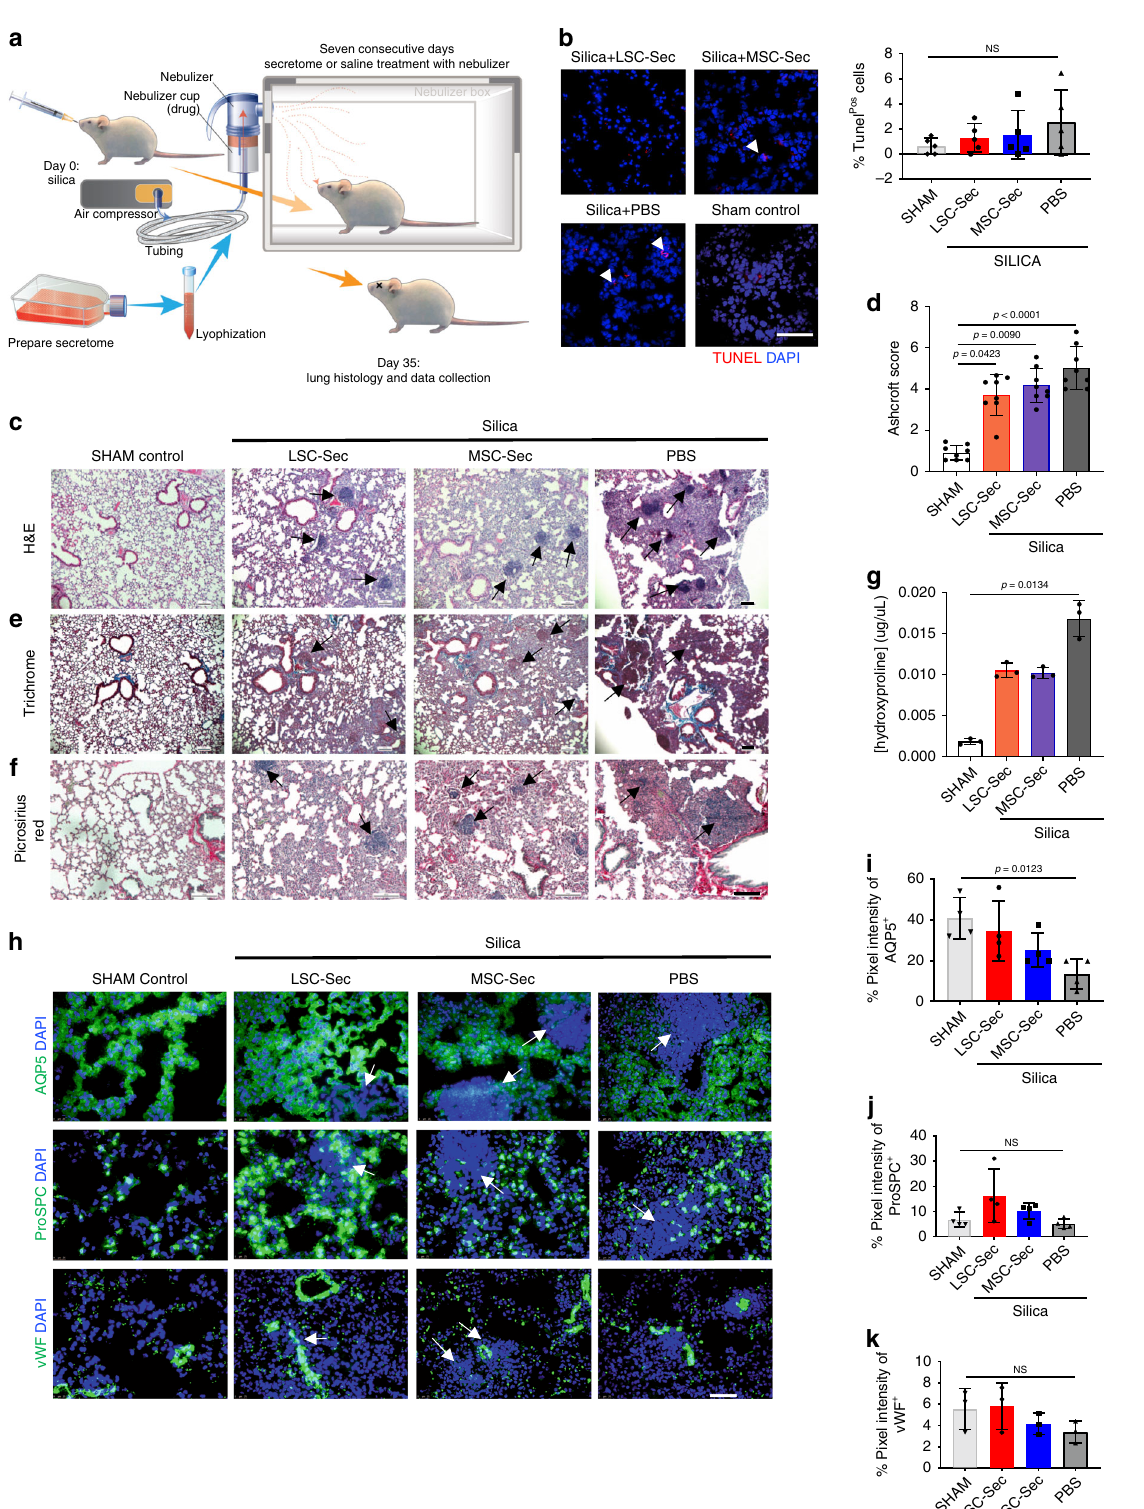
had remarkably similar proteomes, considering that the cell lines were derived from individuals of different sex, race, and age (Fig. 4a). Of the shared proteins, 29.6% were annotated as extracellular proteins with known membrane receptors for secretion, and 47.5% were annotated as cytoplasmic proteins with no known secretion pathways (Fig.